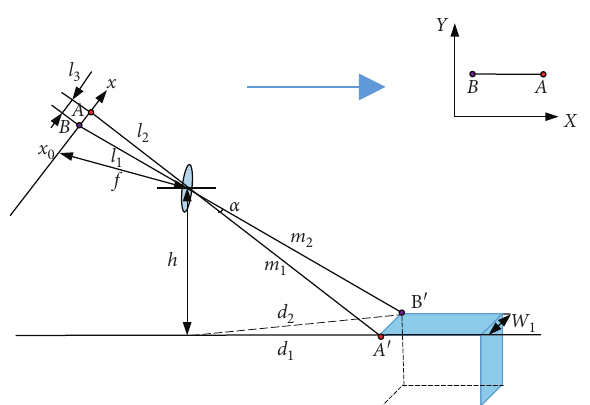
Figure 9: Schematic diagram of static pseudo-obstacle.